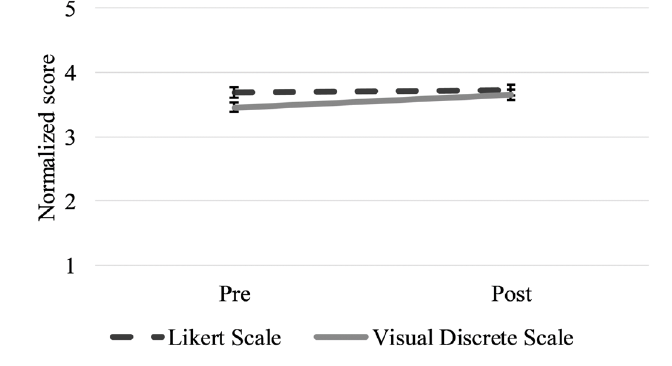
Figure 3. Means of self-concept in science before (Pre) and after (Post) the visit (NLikert scale=446, Nvisual discrete